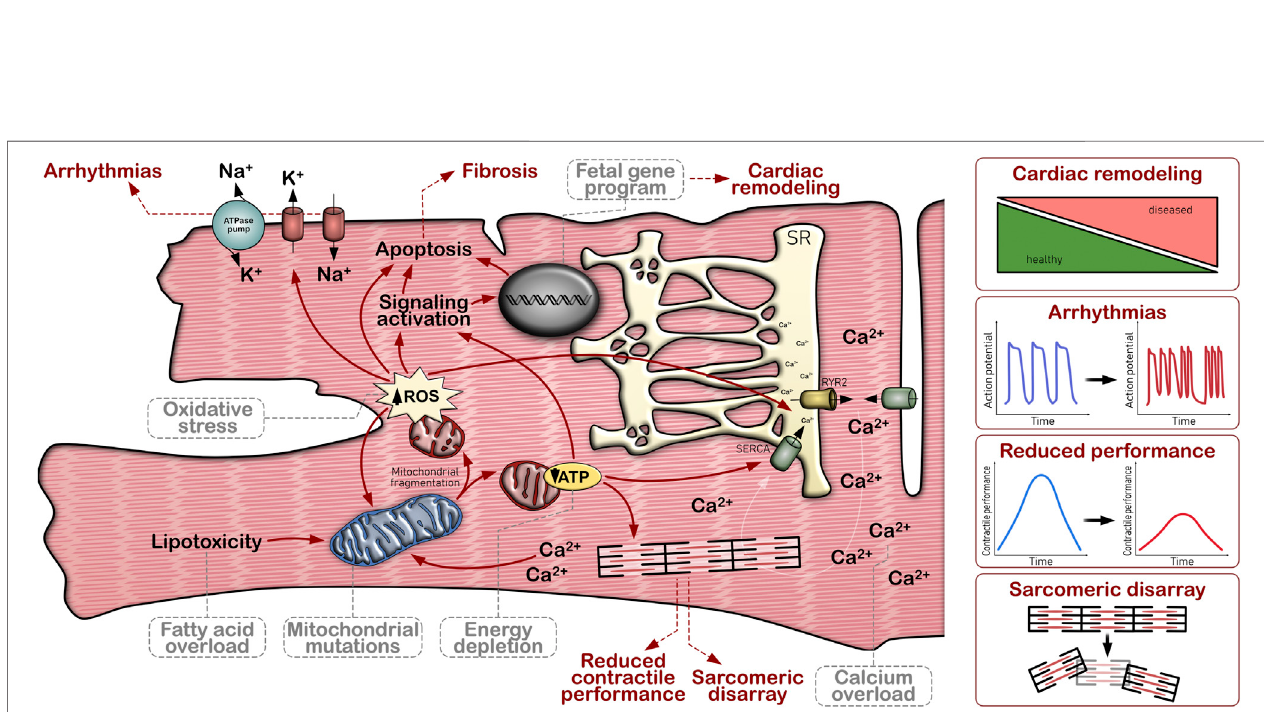
FIGURE 3| Impact of mitochondrial dysfunction on cardiomyocyte pathology. Mitochondrial dysfunction, either caused by gene mutations in mitochondrial genes (primary mitochondrial cardiomyopathy) or as a consequence of other cellular disturbances (such as calcium overload or lipotoxicity), promotes an energy depletion as well as increased ROS production. Poor bioenergetic capacity and oxidative stress provoke, among others, changes in cytosolic calcium handling, electrophysiological defects, reduced contractile performance, sarcomeric re-arrangements, re-expression of fetal genes, cardiac remodeling and apoptosis.